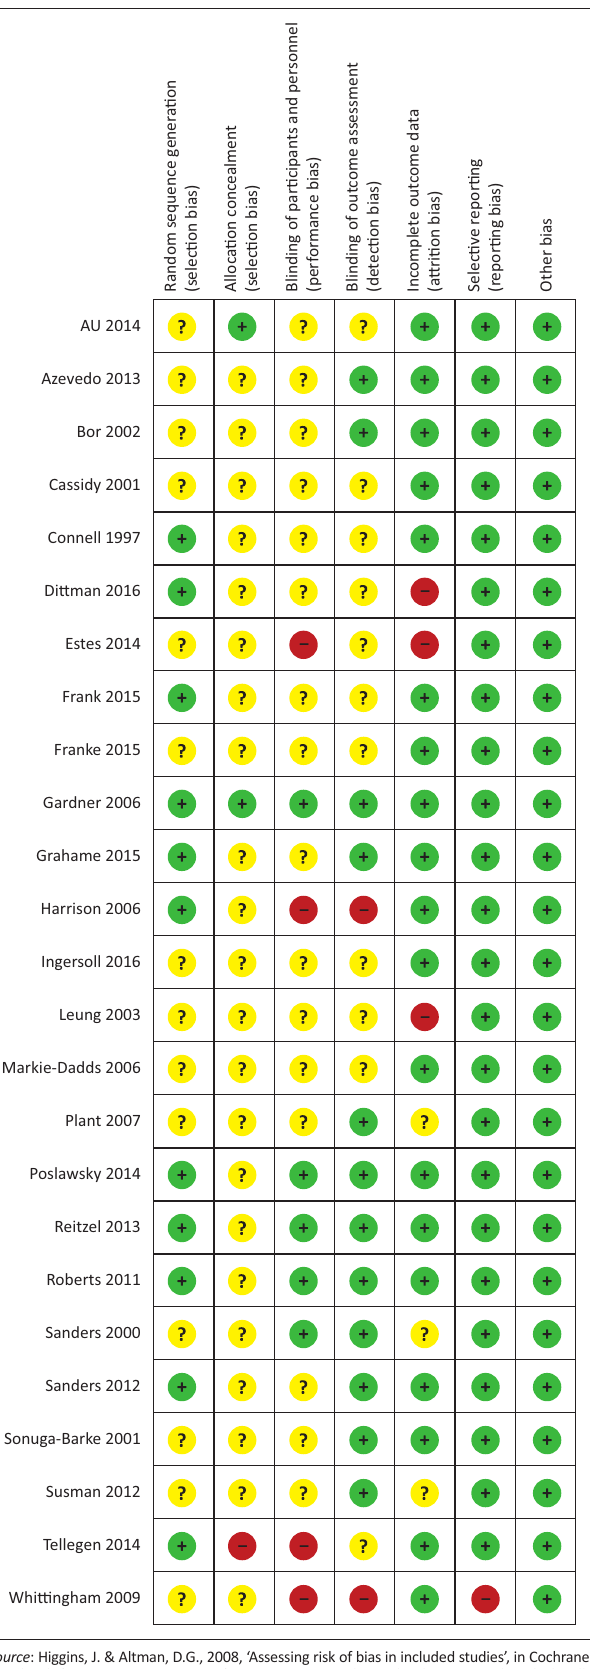
FIGURE 7: Risk of bias assessment for included studies according to Cochrane risk of bias